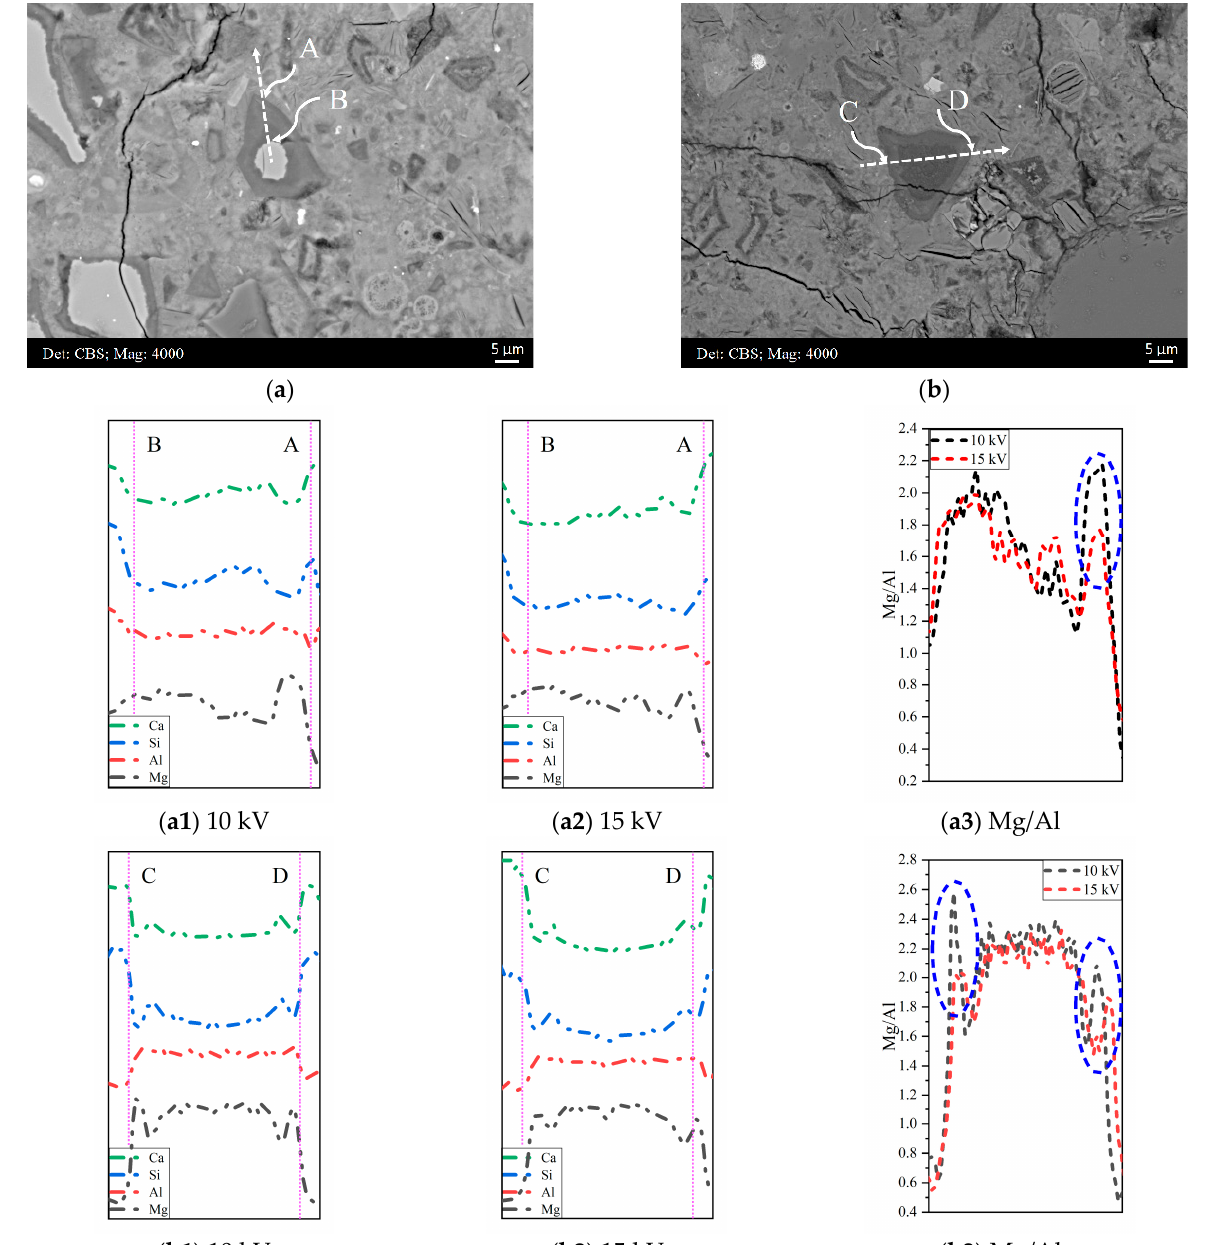
Figure 4. ( a , b ): Two representative BSE micrographs of the microstructure of sample B. EDS line scan-profiles of the elements (Ca, Si, Al, and Mg) along the dissection lines ( a1 , a2 ): A-B; ( b1 , b2 ): C-D under 10 and 15 kV accelerating voltages, respectively. The Mg/Al atomic ratio down the lines ( a3 ): A-B and ( b3 ):